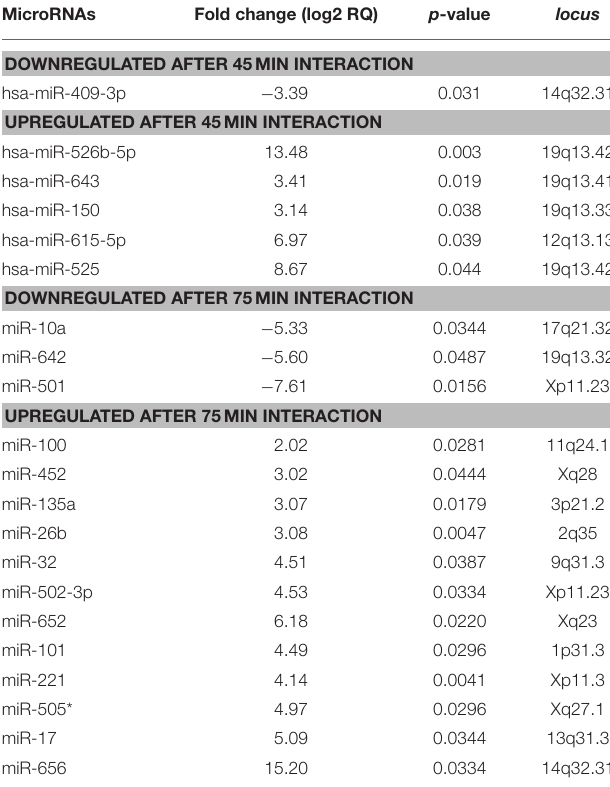
TABLE 1 | MicroRNAs modulated in human SW-480 epithelial colon cells after 45 and 75min interaction with virulent E. histolytica